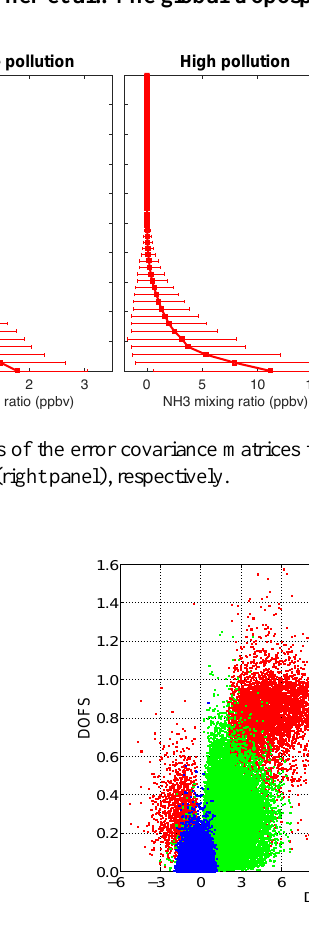
Figure 2. Correlation between the DBTI (difference of brightness temperature index) and DOFS (degrees of freedom for signal) for the three emission scenarios with low pollution in blue, moderate pollution in green, and high pollution in